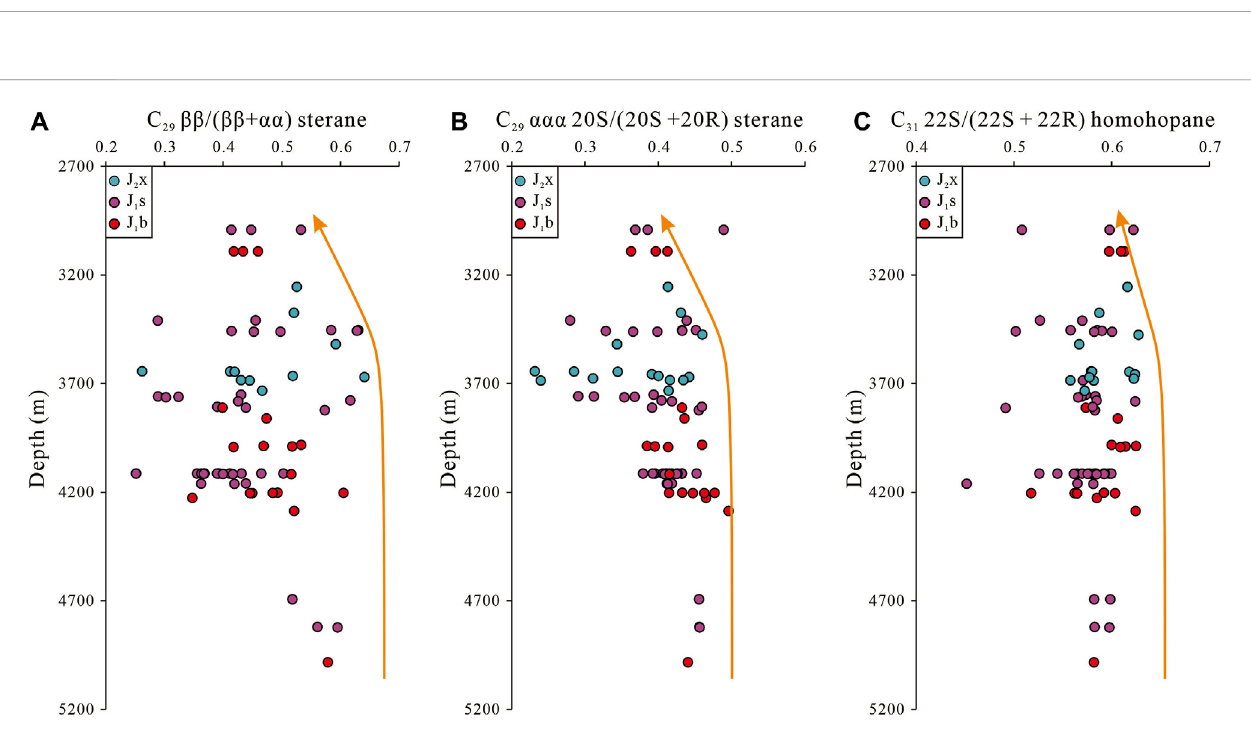
FIGURE 10 Molecular indicators of thermal maturity by sterane isomerization for the Jurassic organic-rich shales in the East Fukang Sag, Junggar Basin, China. (A) C 29 ααα 20S/(20S + 20R) vs C 29 ββ /( ββ + αα ) and (B) 22S/(22S + 22R) C 31 vs C 32 homohopane. equilibrium levels taken from Peters et al., 2005.